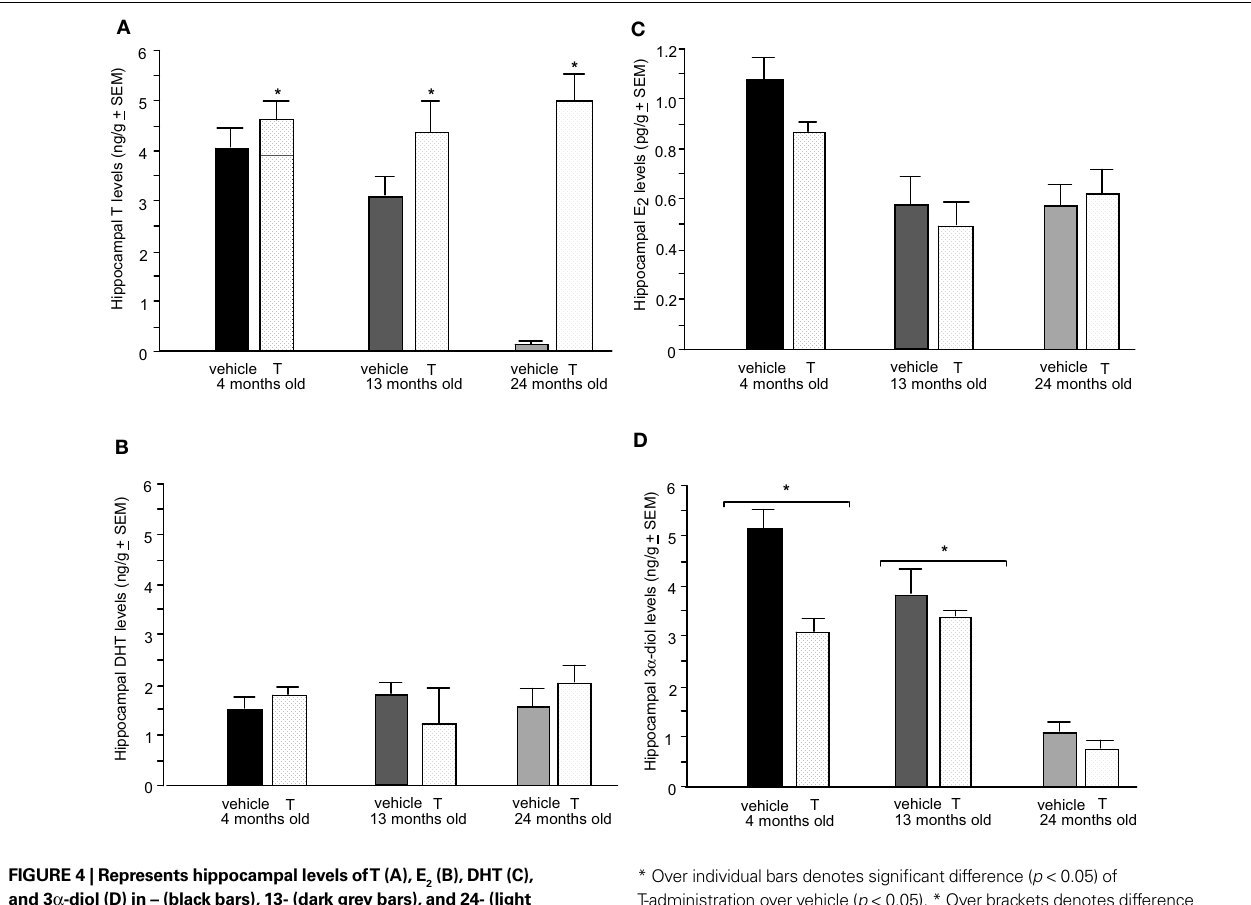
FIGURE 4 | Represents hippocampal levels of T (A), E and 3 α -diol (D) in – (black bars), 13- (dark grey bars), and 24- (light grey bars) month-old intact rats administered subcutaneous injections of sesame oil vehicle (solid bars) or T (stippled bars).